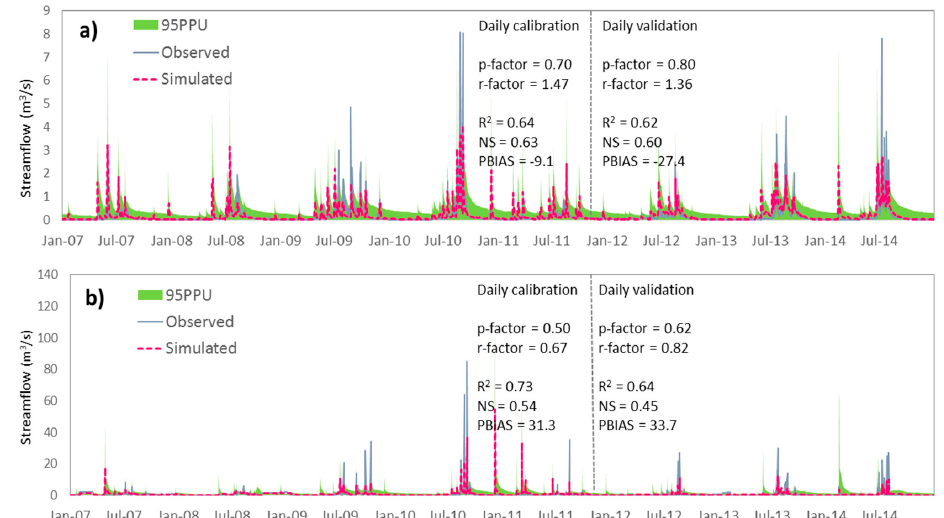
Figure 3. Model calibration and validation with daily time steps for ( a ) Sixth Creek and ( b ) Below Holland Creek. Holland